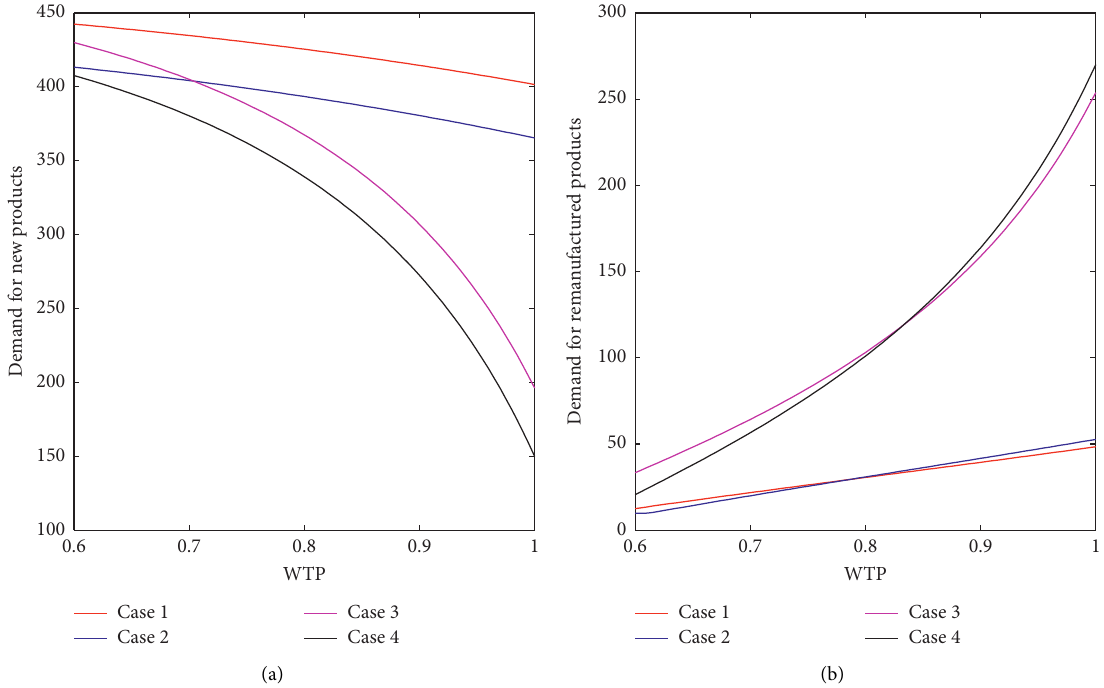
Figure 8: (a) Manufacturing quantity/demand for new products and (b) remanufacturing quantity/demand for remanufactured products vs. WTP.